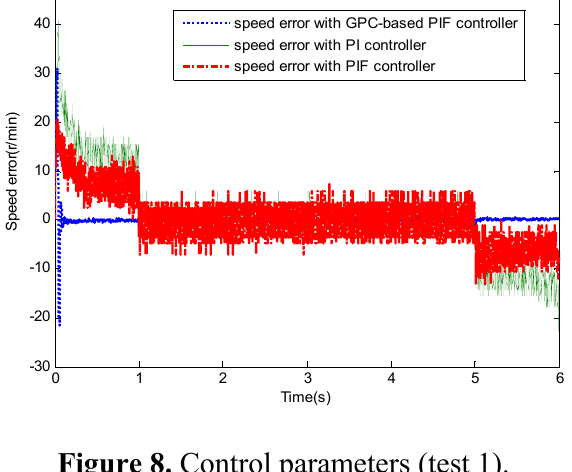
Figure 8. Control parameters (test